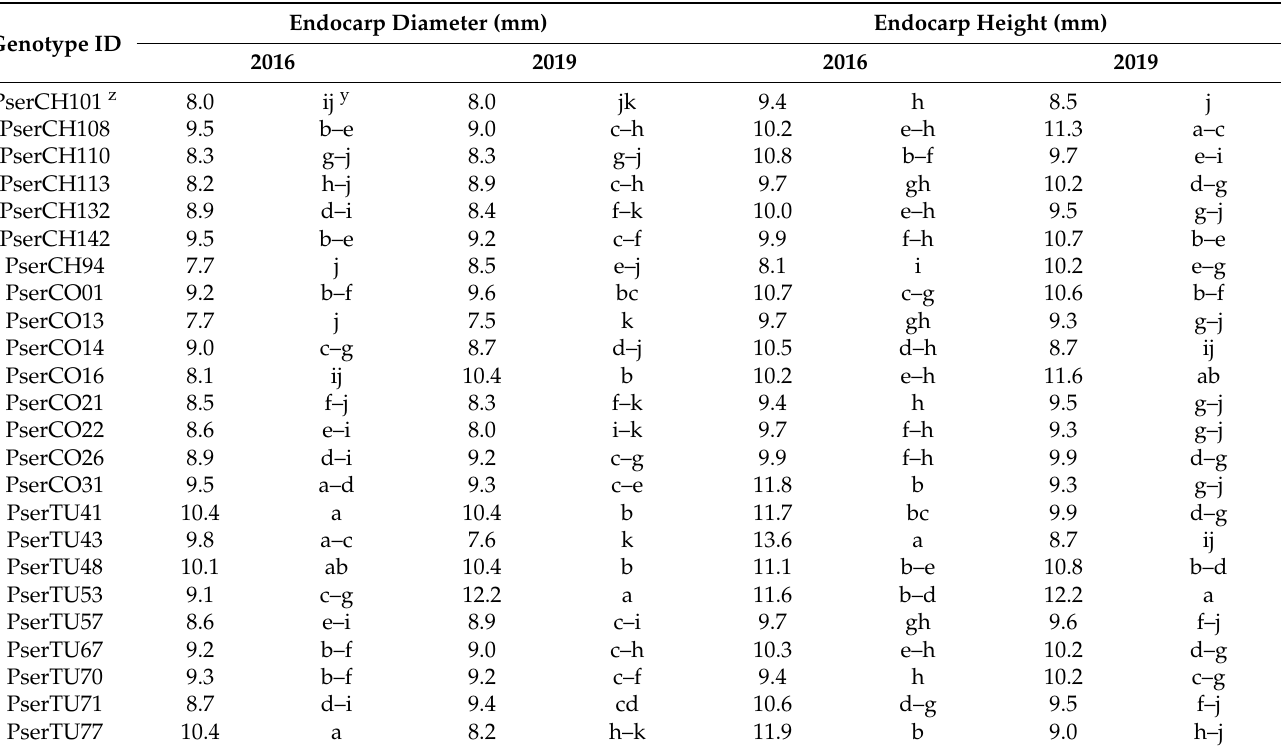
z Genotype: first letter represents the genus (P = Prunus ), next three letters represent the species (ser = serotina ), and the following letters represent the province of origin in Ecuador and collection number (CH101—Chimborazo collection 101). y Different letters within a column indicate significant difference between genotypes, using LSD test at p ≤